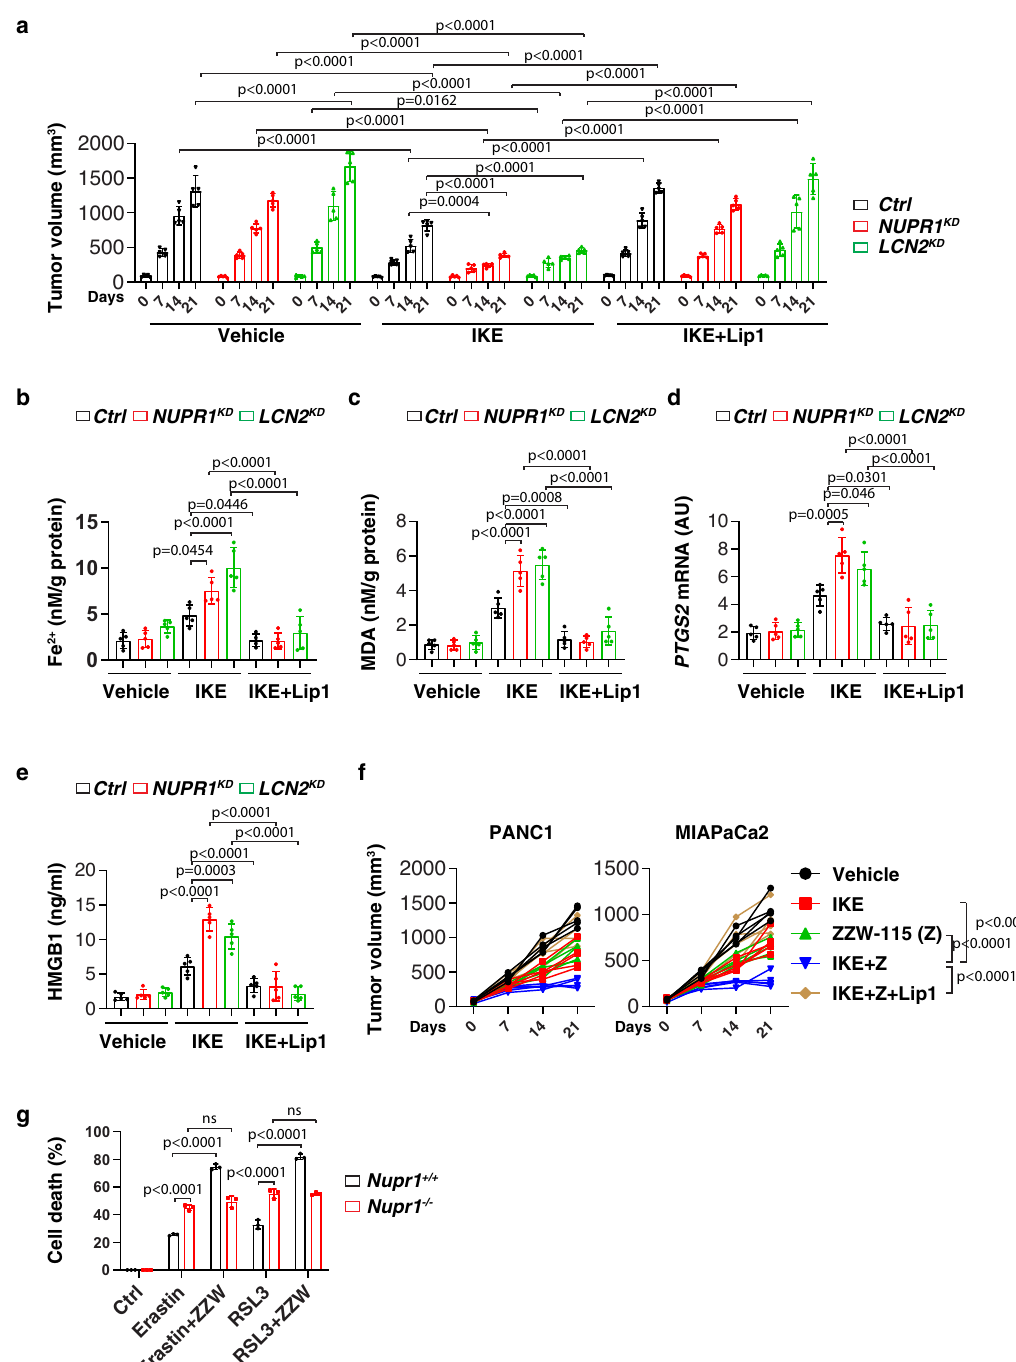
Fig. 5 The NUPR1 – LCN2 pathway limits ferroptotic cancer cell death in vivo. a Athymic nude mice were injected subcutaneously with indicated PDHA1 - knockdown ( NUPR1 KD ) or LCN2 -knockdown ( LCN2 KD ) PANC1 cells for 7 days and then treated with IKE (40 mg/kg, i.p., once every other day) in the absence or presence of liproxstatin-1 (10 mg/kg, i.p., once every other day) at day 7 for 2 weeks. Tumor volumes were calculated weekly ( n = 5 mice/ group; two way ANOVA with Tukey ’ s multiple comparisons test on all pairwise combinations). b – e In parallel, the levels of Fe 2 + ( b ), MDA ( c ), or PTGS2 mRNA ( d ) in isolated tumors and serum HMGB1 ( e ) at day 14 after treatment were assayed ( n = 5 mice/group; one-way ANOVA with Tukey ’ s multiple comparisons test on all pairwise combinations). f Athymic nude mice were injected subcutaneously with PANC1 or MIAPaCa2 cells for 7 days and then treated with IKE (40 mg/kg, i.p., once every other day) in the absence or presence of ZZW-115 (5 mg/kg, i.p., once every other day) or liproxstatin-1 (10 mg/kg, i.p., once every other day) at day 7 for 2 weeks. Tumor volumes were calculated weekly ( n = 5 mice/group; two-way ANOVA with Tukey ’ s multiple comparisons test on all pairwise combinations). g Indicated mPDAC cells were treated with erastin (10 µ M) or RSL3 (1 µ M) in the absence or presence ZZW-115 (2 µ M) for 24 h and then cell death was assayed ( n = 3 well/group, two-way ANOVA with Tukey ’ s multiple comparisons test on all pairwise combinations). ns: not signi fi cant. Data in a – e and g are presented as mean ± SD. The results in a – g are representative of those from 2 to 3 independent